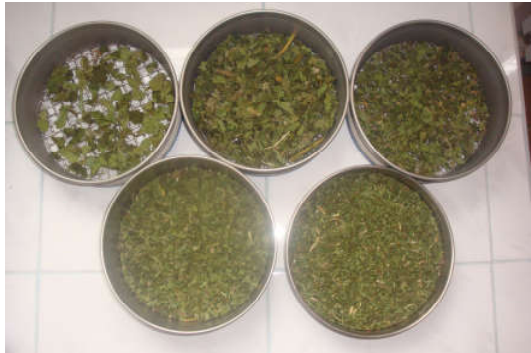
Figure 2. Nettle fragments separated on the sieves of the Retsch classifier.